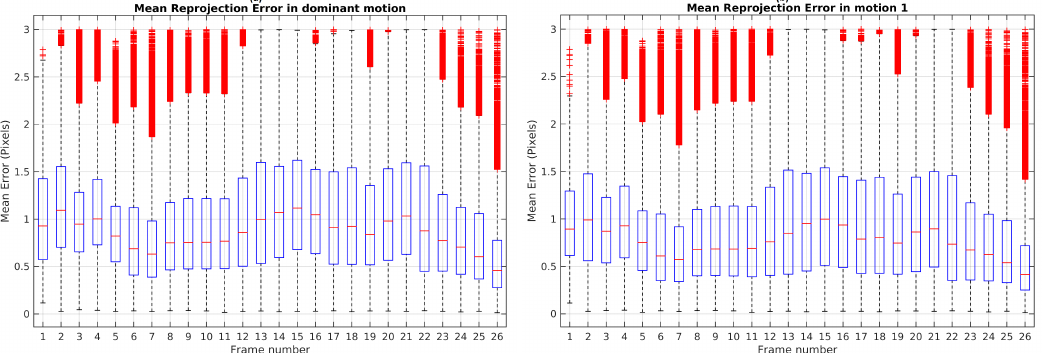
Figure 10. Mean reprojection error for Scene 3: ( a ) Dominant motion; ( b ) Dynamic object.